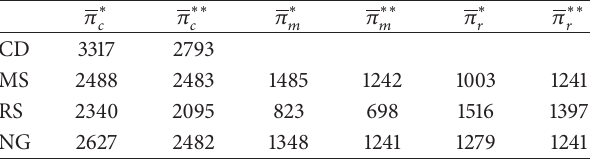
Table 3: Optimal